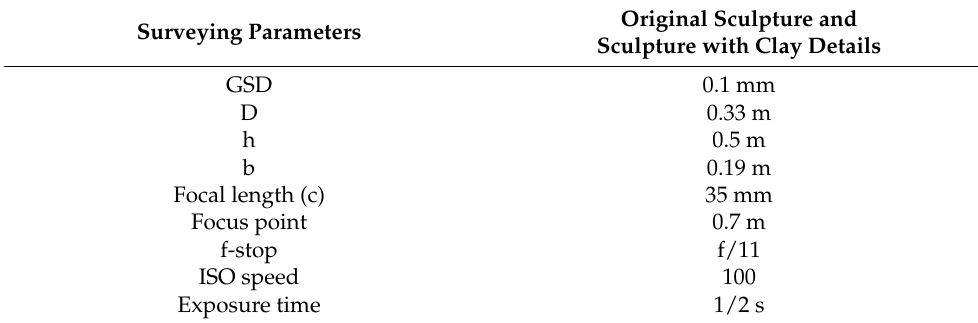
Figure 2. Overview of the shooting plan in the laboratory: ( a ) sketch of the shooting plan; ( b ) realistic set-up of elements in the laboratory. Table 1. Parameters for photogrammetry